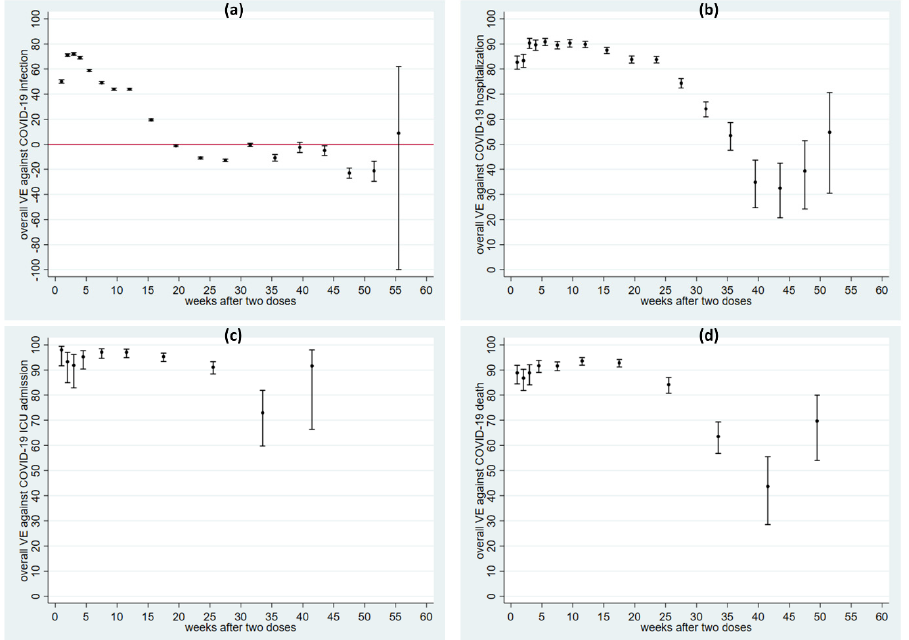
Figure 1. Adjusted vaccine effectiveness (dots) with 95% CI (capped spikes) against COVID-19 infection (panel ( a )), hospitalization ( b ), severe outcomes [ICU admission ( c ), and death ( d )] at each time interval after two doses. Note that the y-axis scales are different for infection ( a ) and the other outcomes. Legend: VE denotes vaccine effectiveness. The red line in ( a ) indicates VE = 0.